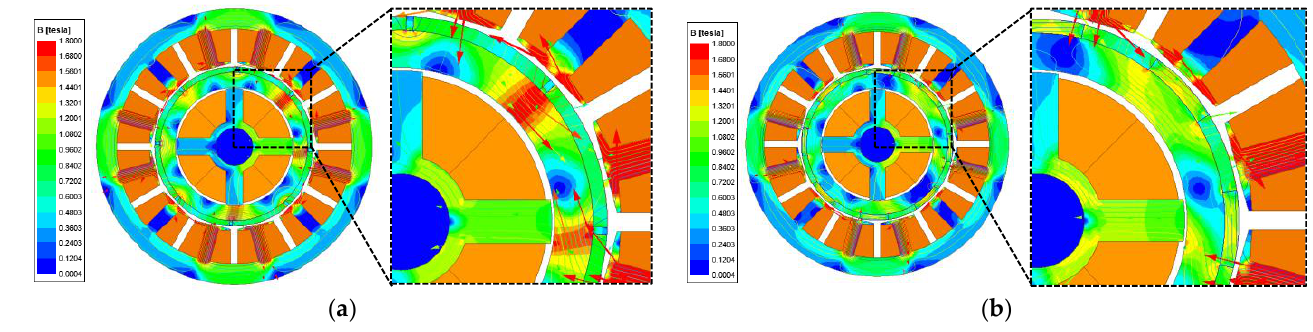
Figure 14. Rotor magnetic flux density plot: Tangential PM angle: ( a ) 2° mechanical; ( b ) 22° me- chanical.